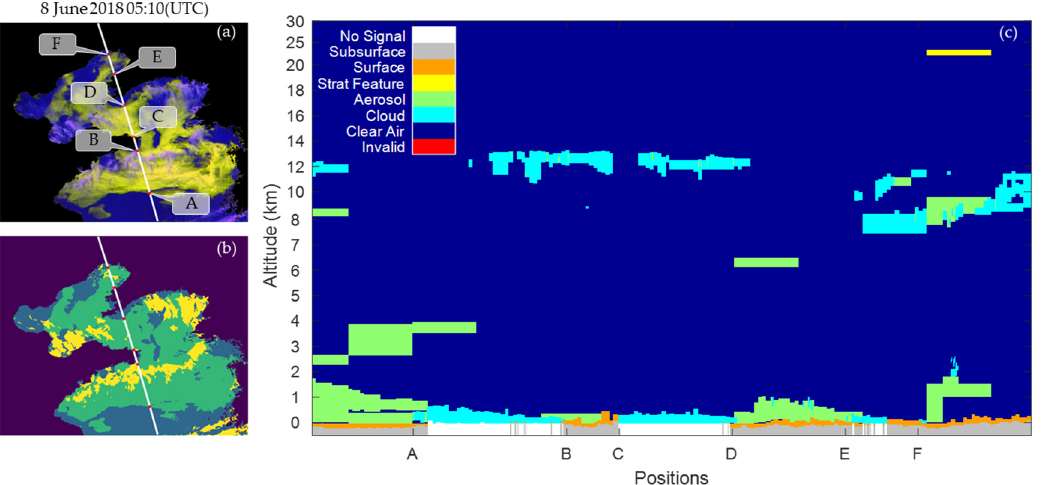
Figure 7. The fog detection results and VFM validation of the proposed method. ( a ) The original Himawari-8 false-color image composited by band 04, band 05, and band 07, while the white solid line indicate the CALIOP orbit track; ( b ) the clear sky, clouds and sea fog regions detected by our model, corresponding to blue, yellow, and green colored pixels; ( c ) visualization of the VFM derived from the CALIPSO backscatter data along the footprint line on 8 June 2018, light blue, green, and orange indicate regions of “clouds”, “aerosols”, and “surface” with high confidence, respectively.